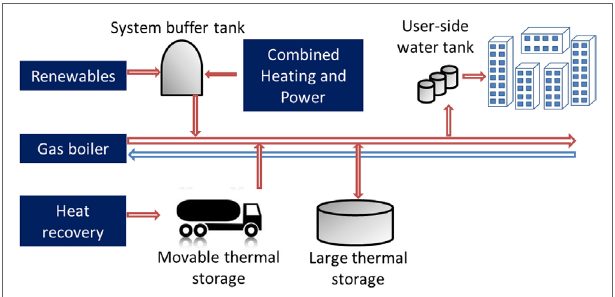
FigURe 1 | Different thermal energy storage systems in a multisource heat